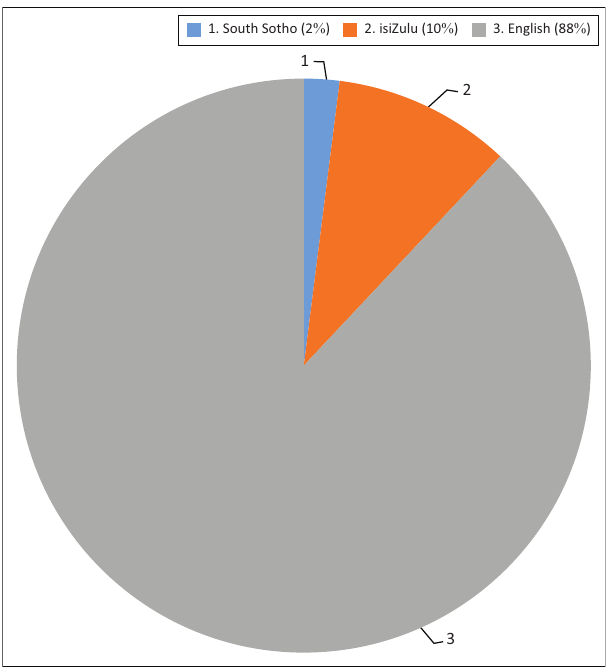
FIGURE 4 : Languages used when administering questionnaires.